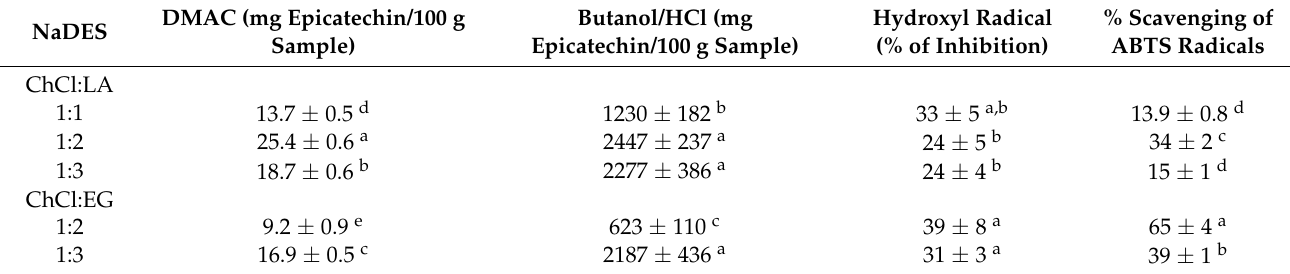
Table 3. Total PA content (DMAC and butanol/HCl assays) and total antioxidant capacity (ABTS and capacity to inhibit the formation of hydroxyl radical assays) obtained from the extraction residue of mangosteen peel using UAE, with ChCl:LA and ChCl:EG at different molar ratios (1:1, 1:2, and